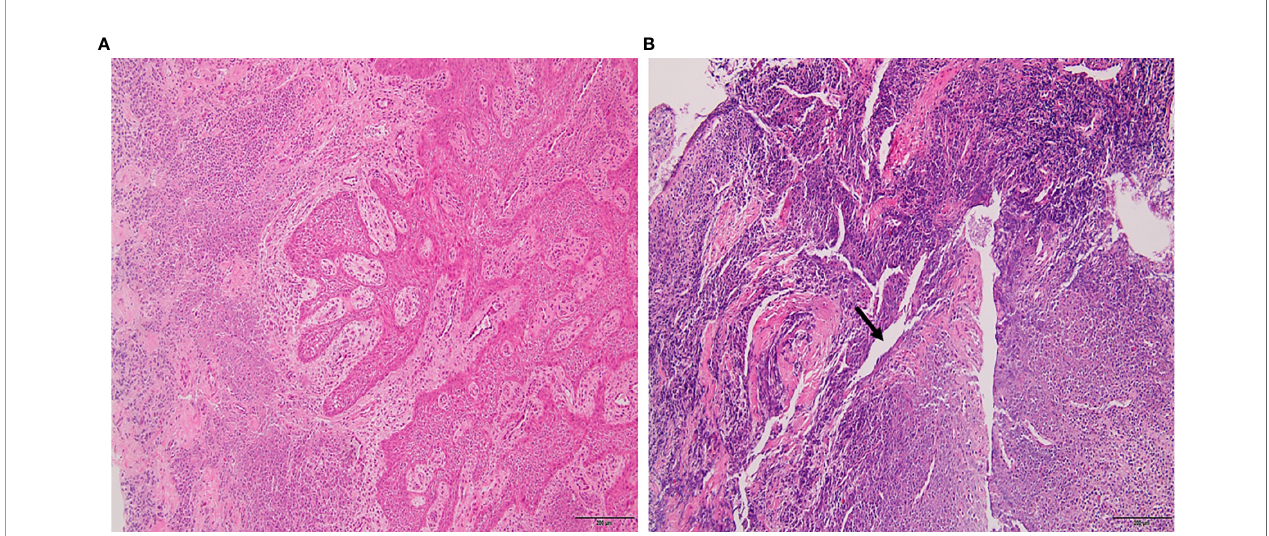
FIGURE 1 | Histopathology of periapical lesions. (A) Periapical granuloma with well-organized epithelium and connective tissue in fi ltrated with in fl ammatory cells. (B) Radicular cyst with epithelialized lumen and chaotic arrangement of cells. An arrow indicated the lipid cleft in radicular cyst. Tissues were stained with hematoxylin and eosin with ×10 magni fi cation